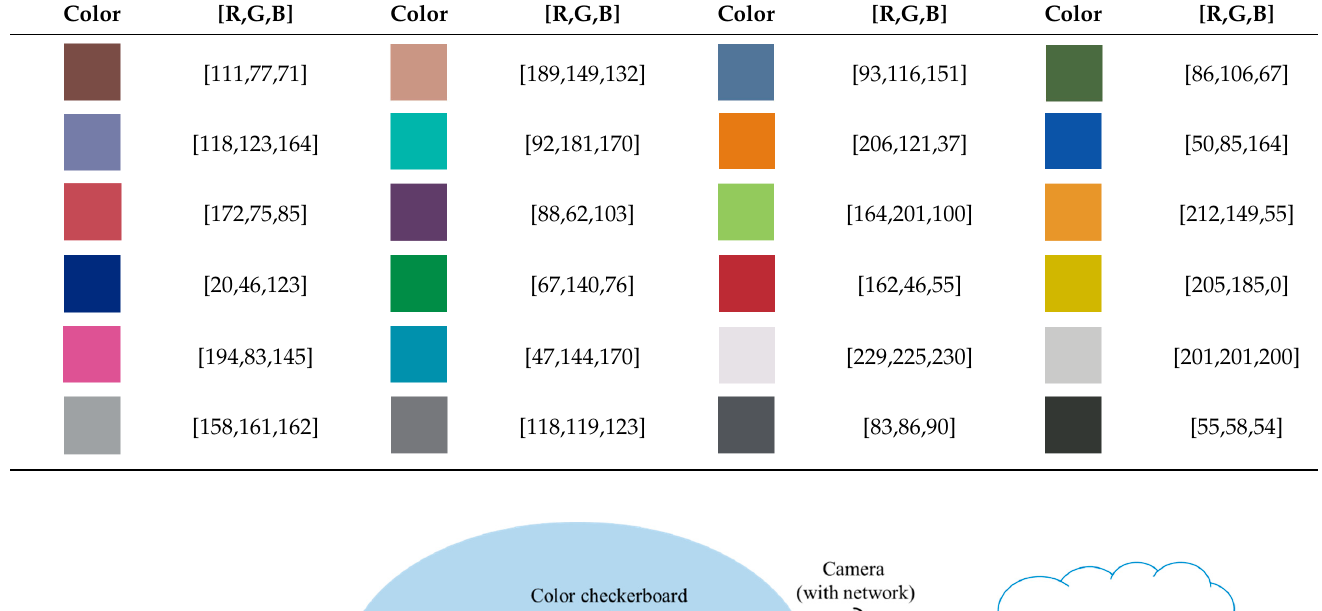
Figure 3. The proposed system established at the experimental site. Table 1. The 24 colors used in our color checkerboard.